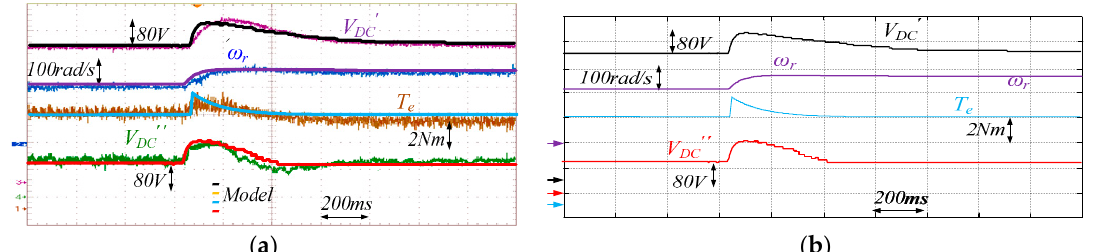
Figure 24. Speed transient from ω r = 200 rad/s to ω r = 260 rad/s under a constant resistor value R L = 80 Ω and V DC ' = 400 V, V DC ''= 100 V. Output voltage V DC ' , TLI DC bus voltage V DC '' , rotor speed ω r , electromagnetic torque T e . ( a ) Experimental results. ( b ) Simulation results.